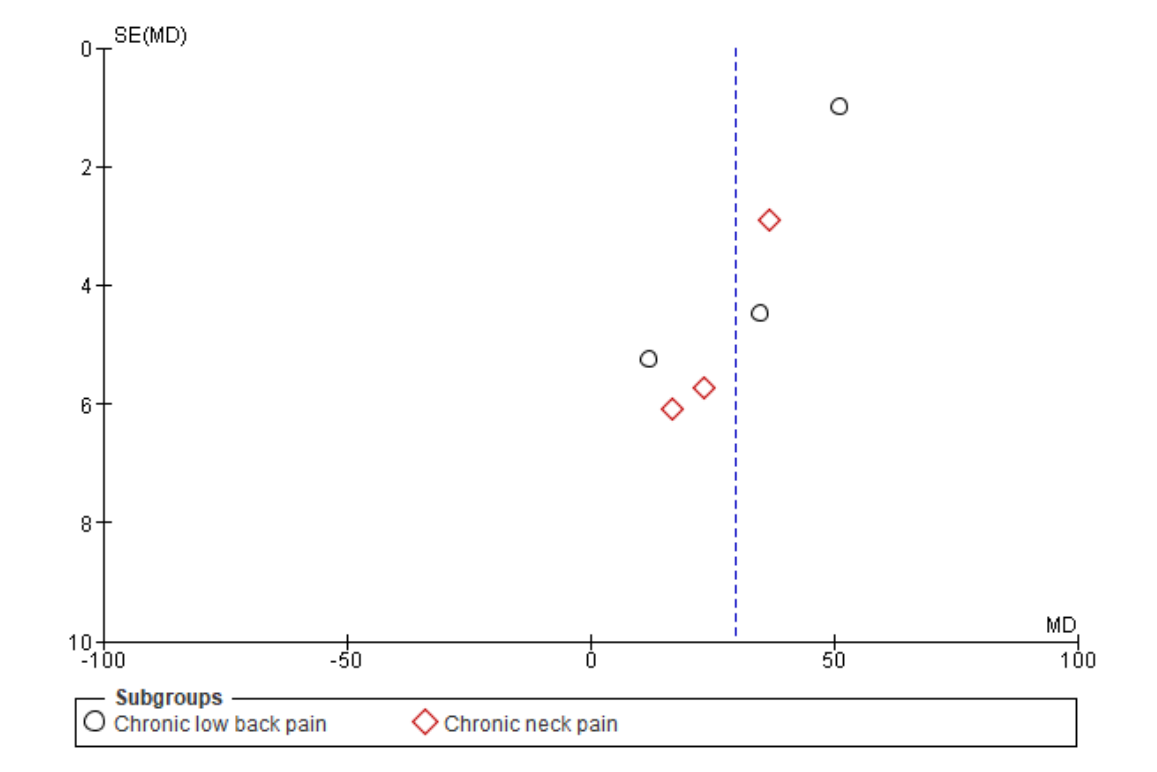
Figure 11. Funnel plot pre- and post-VR pain management intervention.